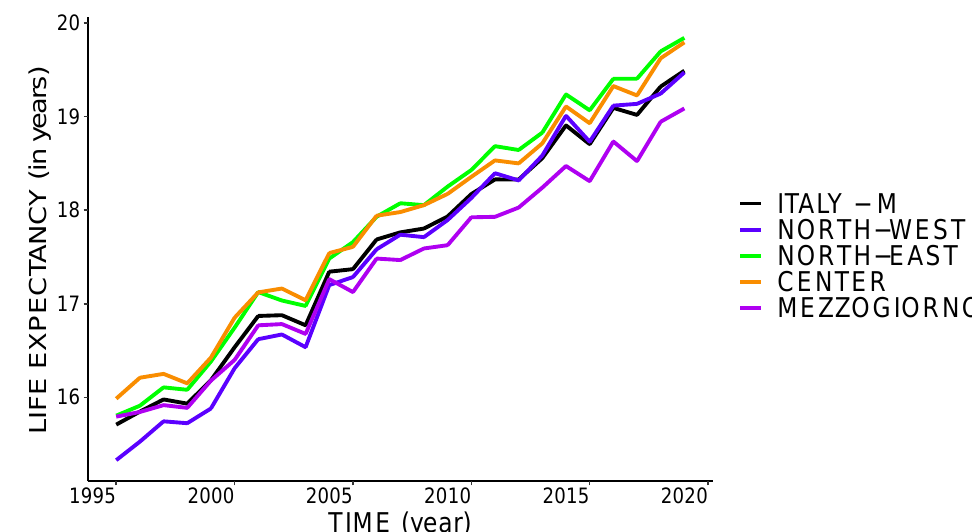
Figure 3. Life Expectancy at age 65 among female ( top ) and male ( bottom ) populations in Italian macroareas (NUTS-1 level) during 1995–2019. Source: ISTAT.